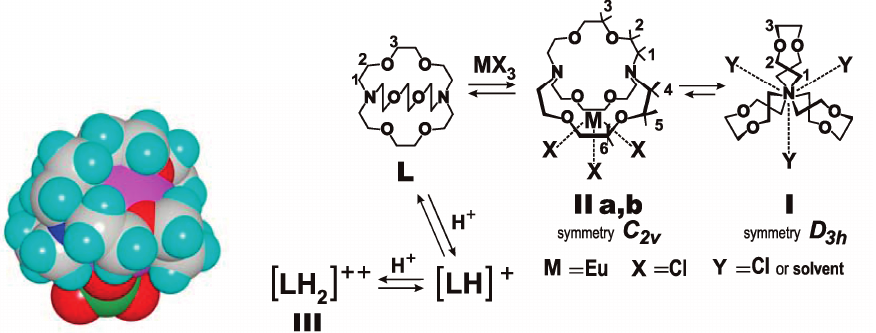
Figure 16. Complex of europium ion and a (222) cryptand, crystal structure with the metal ion inside [65] and structures with the metal in different locations, as observed in solution by NMR spectroscopy [66]. Partially reprinted from ref. [65] with permission of the Royal Society of